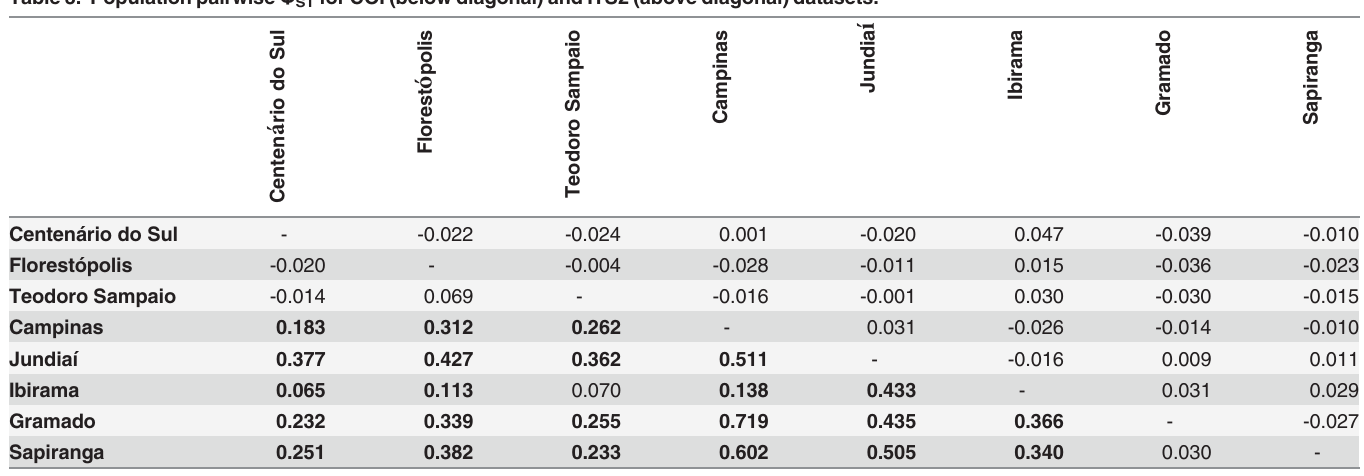
Table 3. Population pairwise Φ ST for COI (below diagonal) and ITS2 (above diagonal)